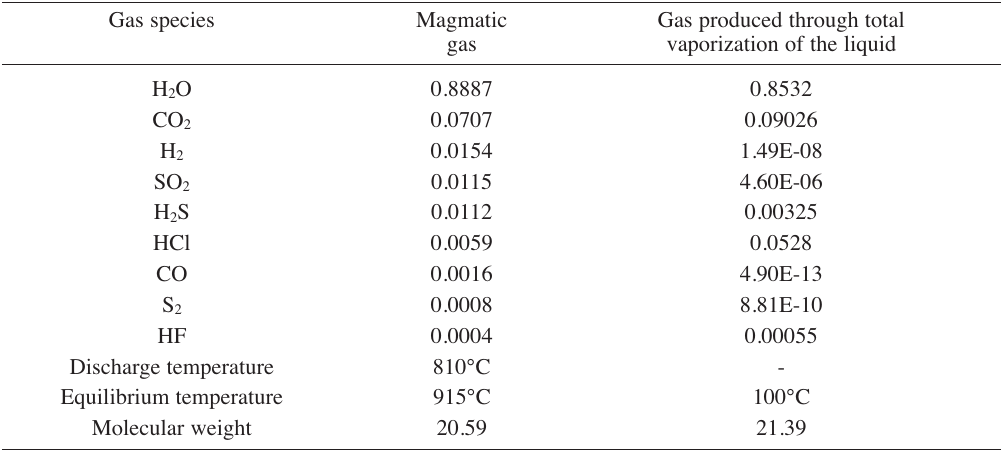
Table I. Chemical composition (molar fractions) of the magmatic gas and of the gas produced through total va- porization of the liquid phase. Sample 79-2 from Merapi Volcano, Indonesia (Le Guern et al ., 1982) is consid- ered to be representative of the magmatic gas by Symonds et al . (2001) and in this study as well. Gas